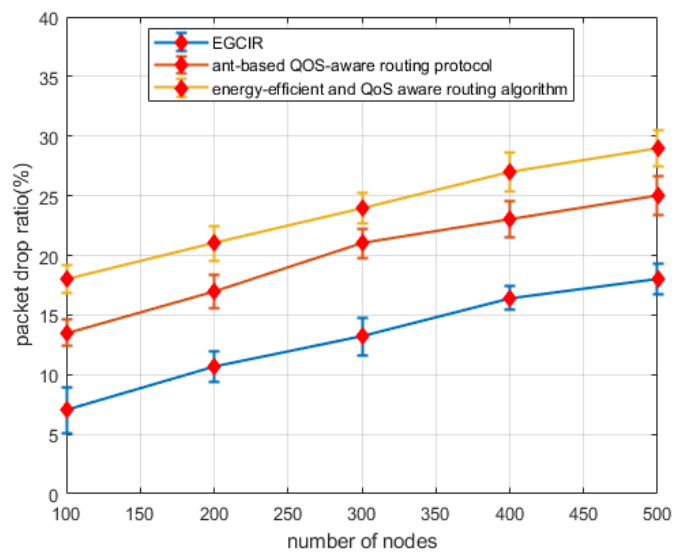
Figure 3. Impact of the nodes and packet drop ratio.